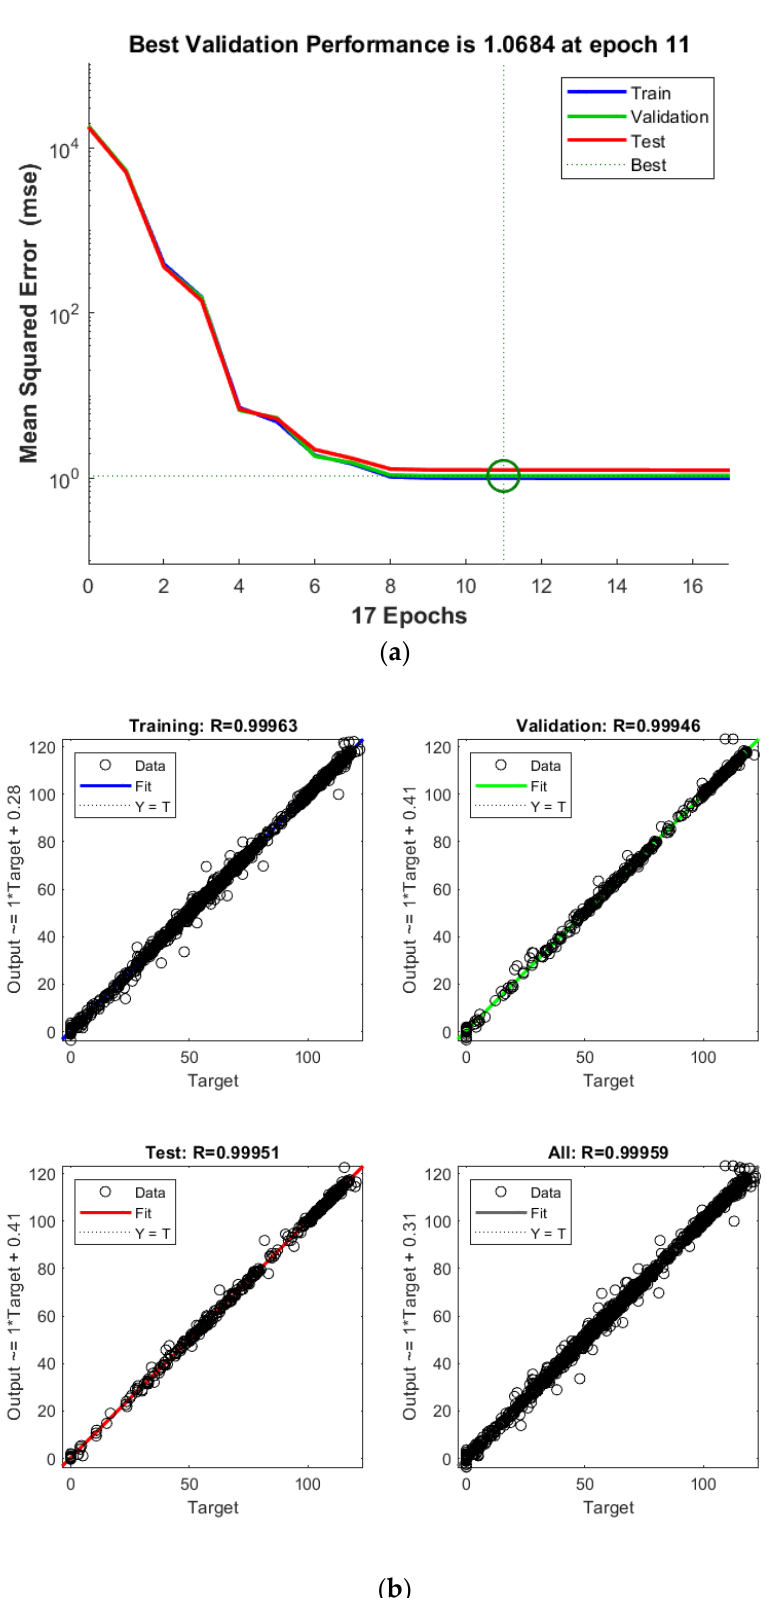
Figure 19. The training performance of the trained NARX network. ( a ) The MSE performance of the trained NARX network; ( b ) the regression performance of the trained NARX network.